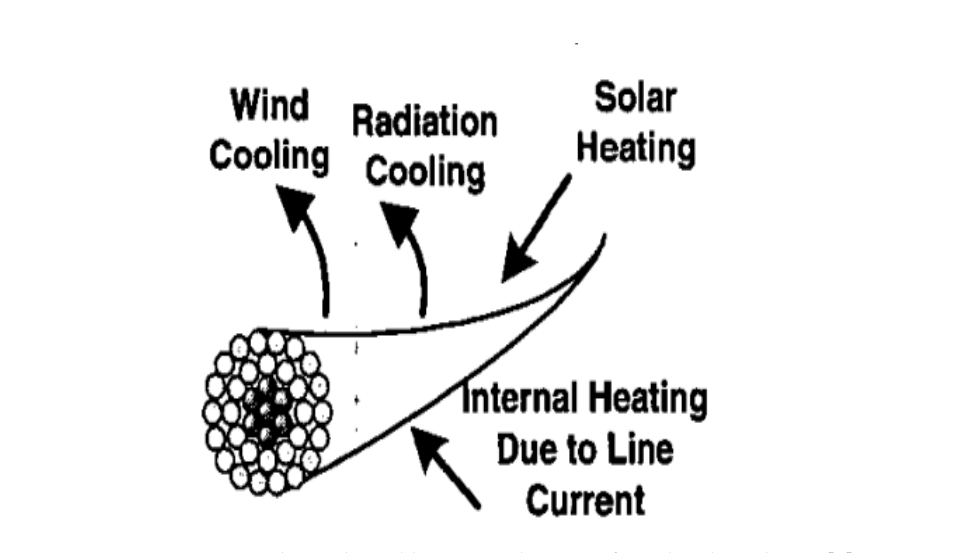
Figure 2. Thermal equilibrium mechanism of overhead conductor [9].